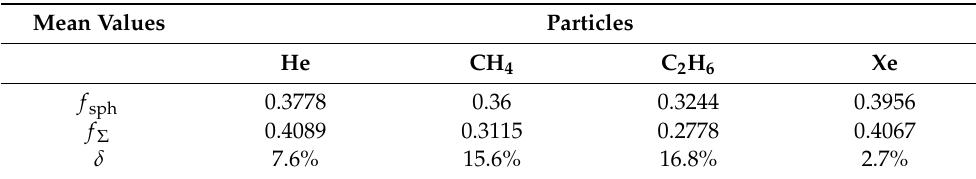
Figure 7. Probability density functions for particles moving with the same initial velocity v 0 p . Table 2. Average values of the fraction of passed particles ( f ) calculated by the integral and additive methods.